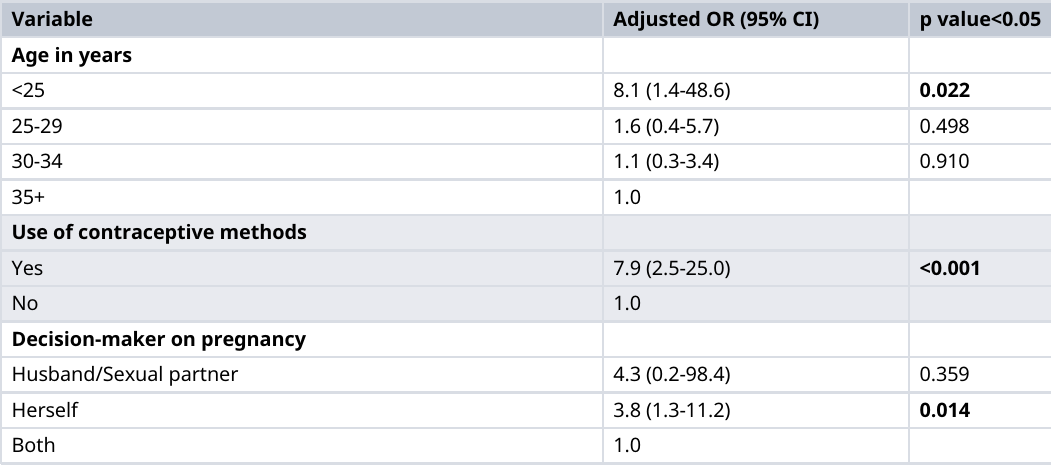
Table 5. Multivariate logistic regression analysis: Factors associated with unintended pregnancy among women attending Antenatal clinic at Kenyatta National Hospital, Nairobi.